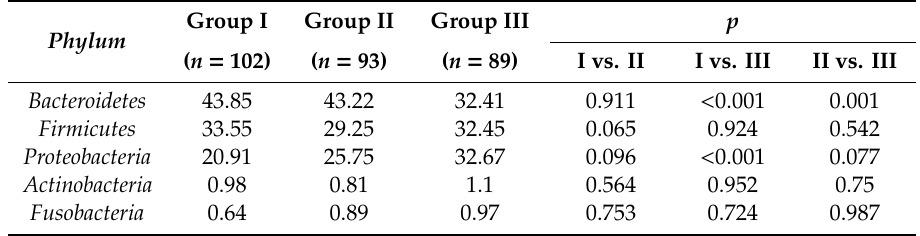
Table 2. Comparison of the mean relative abundance (%) at phylum level in C. di ffi cile- non colonized (group I), colonized (group II), and diarrhea with C. di ffi cile (group III). Group I Phylum